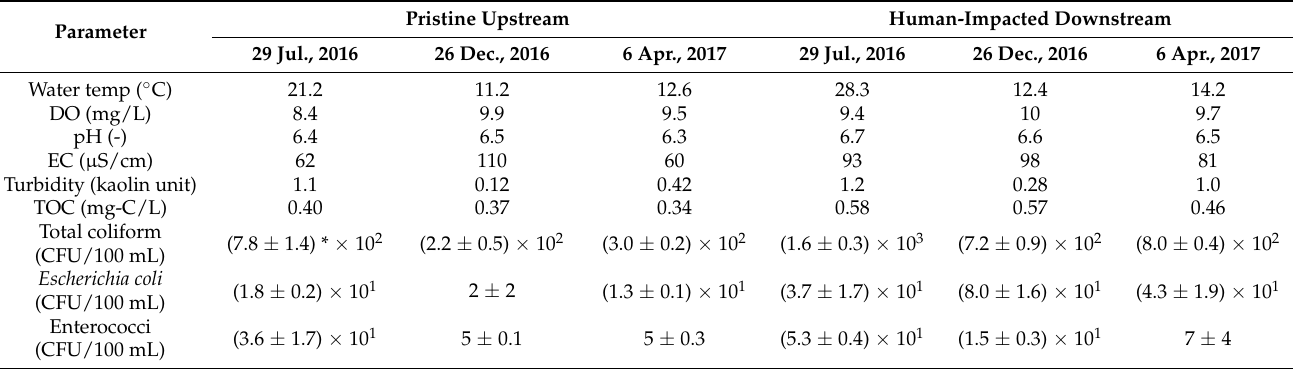
Table 1. Water qualities and bacterial counts at each site during survey